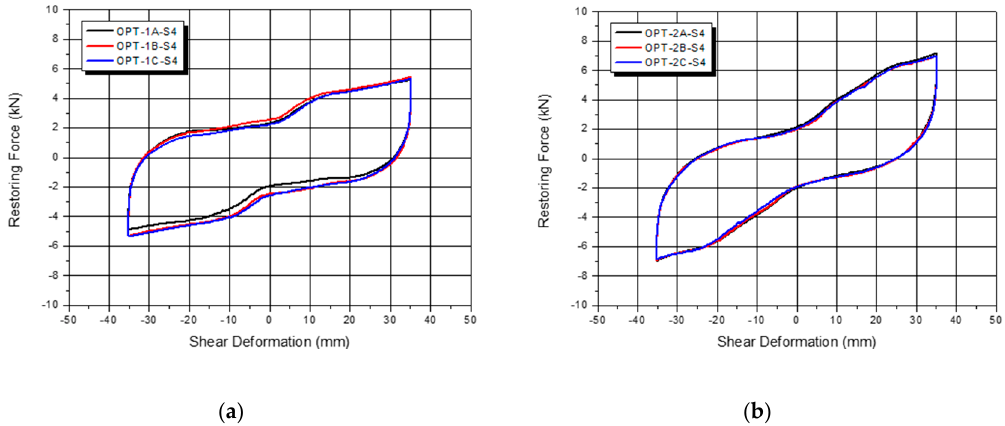
Figure 13. Test results for design shear deformation range ( ± 35 mm): ( a ) OPT-1; ( b ) OPT-2.